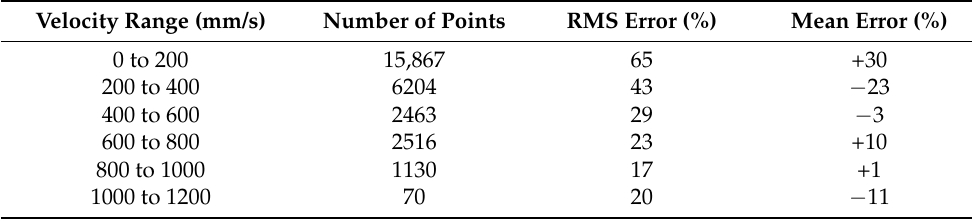
Table 3. Sensor error characterisation. RMS error calculations for the sensor measurement in in-field testing. A negative mean error corresponds to the sensor under-reading. Data are binned according to the velocity recorded by the HACH